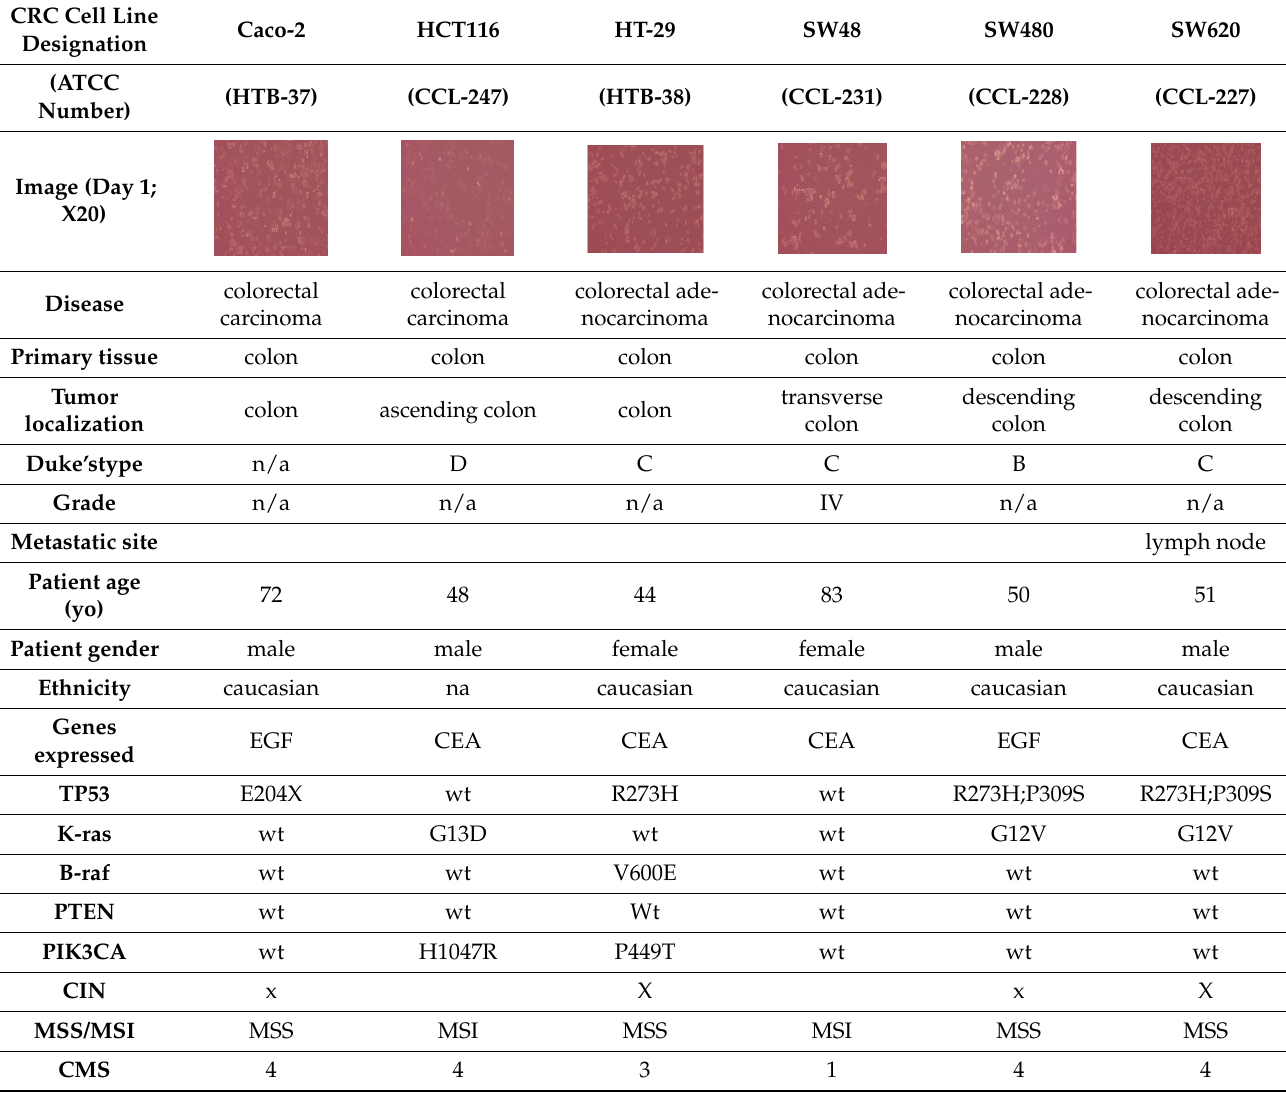
Table 4. Characteristics of the six colorectal cancer (CRC) cell lines used in the study, including molecular characteristics (mutations are annotated at the protein level, as described by den Dunnen et al. [45]; wt: wild type) and the relevant consensus molecular subtypes (CMS) groups according to Sveen et al. [38].